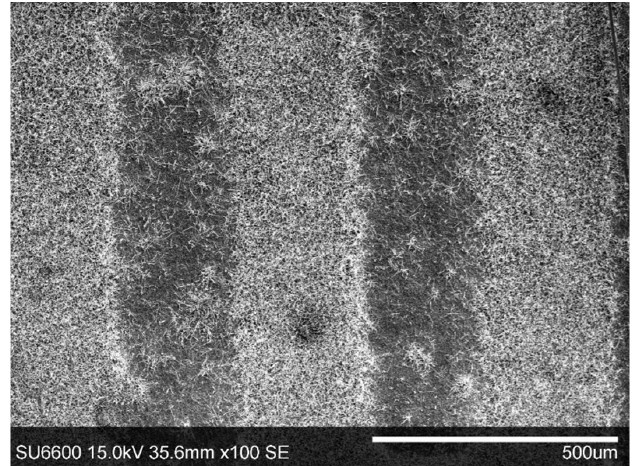
Figure 4. SEM image of the inter-electrode area/surface of the substrate with visible agglomerates